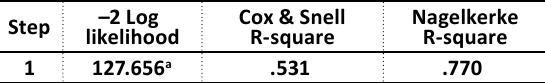
Table 6. Testing the fit of the model